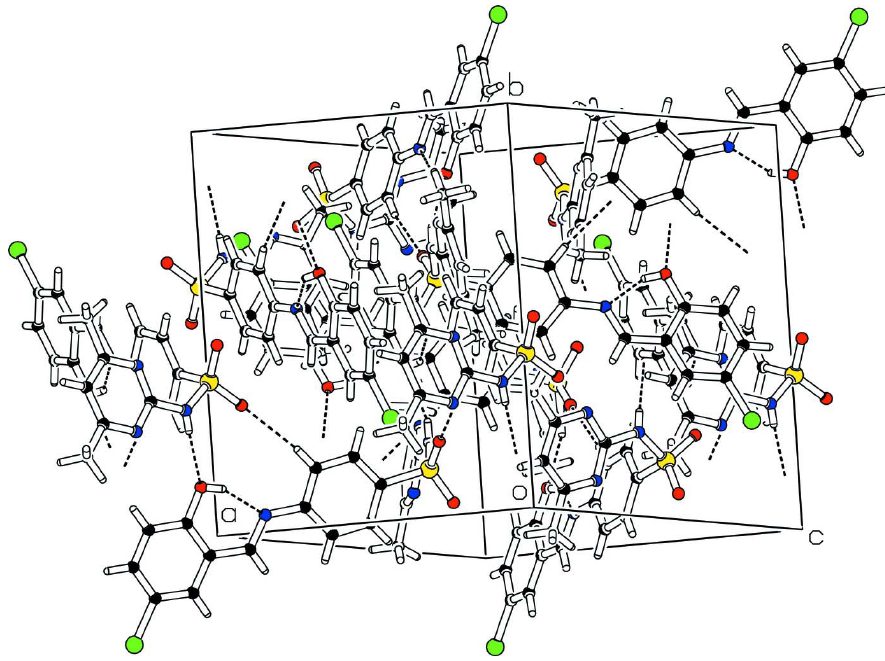
ORTEP - 3 for Windows (Farrugia, 1997) drawing of the title compound, C scheme. The thermal ellipsoids are drawn at the 50% probability level. H-atoms are shown by small circles of arbitrary radii. The intramolecular H-bonding is shown by dashed lines.